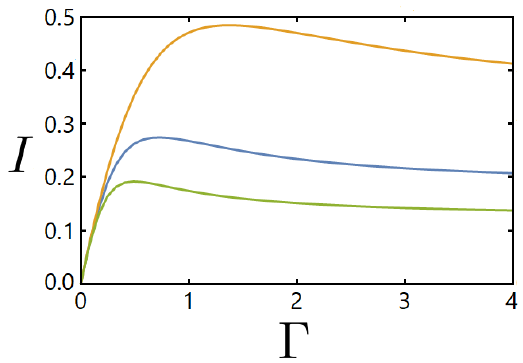
Figure 6: Total current across the junction and mean occupation number as a function = 0.1, t ( (cid:96) ) = 1 and α = 0.25 (green curve), α = 0.5 (blue curve) of Γ for γ = 3, γ C and α = 0.75 (orange curve).